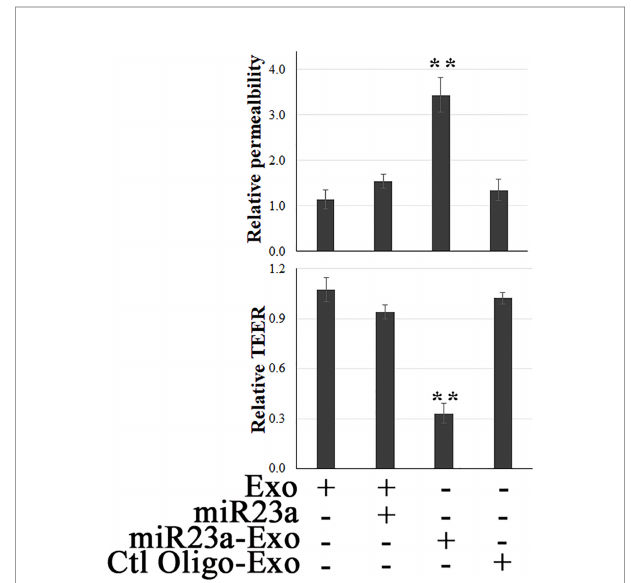
FIGURE 3 | Exosomal miR23a impairs the barrier function of recipient BMECs. FITC-dextran-based assays (46) and TEER measurements (26) were performed in normal human BMECs following treatment with naked miR23a mimics (2 x 10 -5 pmol/cell), ECExos (1,000 particles/cell), Ctl Oilgo-, or miR23a mimic-enriched ECExos (miR23a-Exo) (1,000 particles/cell) for 72 hrs. ** p